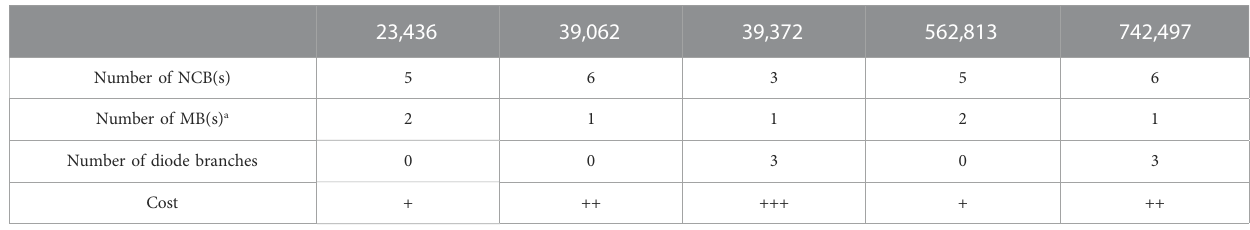
TABLE 6 Comparison in two common connection points